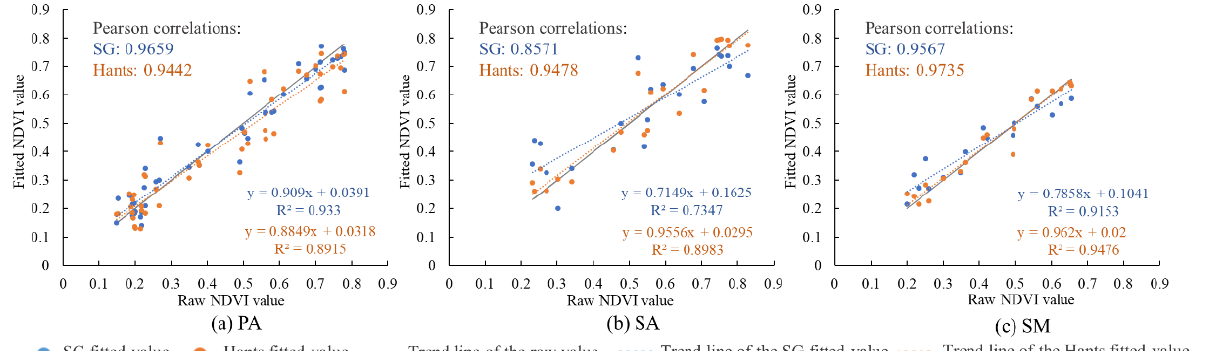
Figure 3. Comparison of the fitting effects of the Hants and Savitzky–Golay (SG) filtering methods for the mean normalized